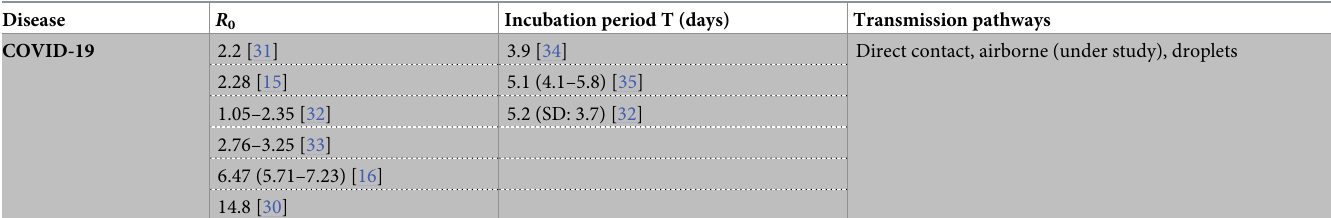
Table 1. Key virus transmission parameters.